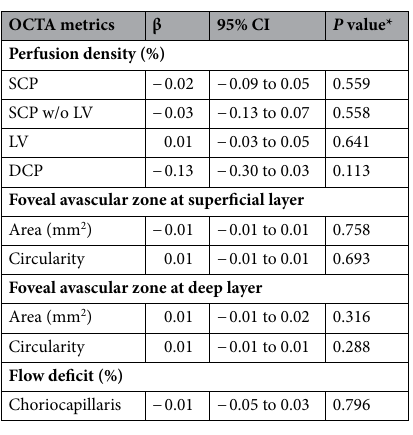
Table 4. Univariate analysis of optical coherence tomography angiography parameters with duration of MS. CI confidence interval, DCP deep capillary plexus , LV large vessels, OCTA optical coherence tomography angiography, SCP superficial capillary plexus.